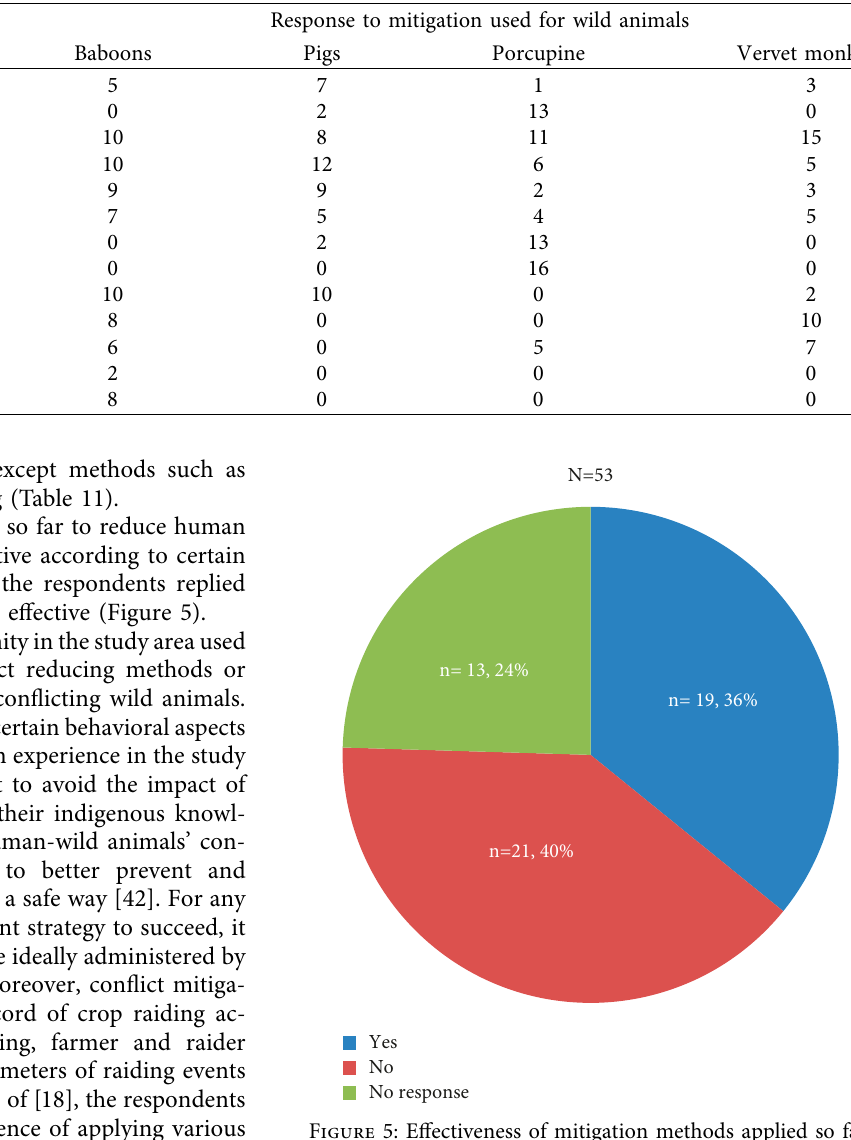
Table 11: Mitigation strategies applied to human and wild animal conflict.